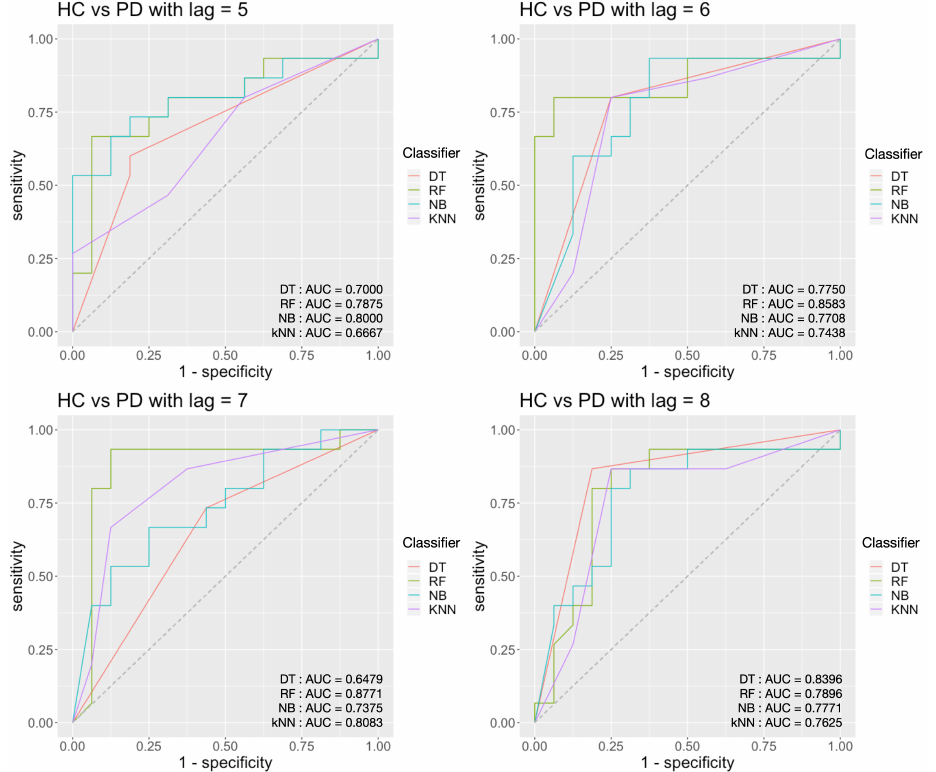
Figure 13. Classification results for HC vs. PD with an embedding time delay lag of 5, 6, 7 and